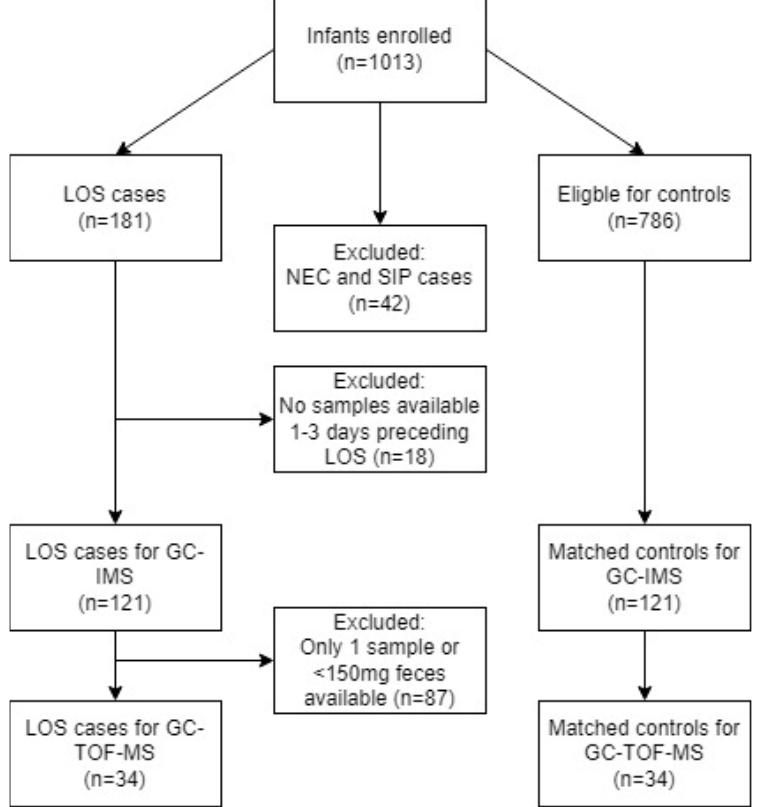
Figure 1. Flow diagram of included preterm infants. A total of 121 LOS cases was included for analysis and matched to 121 controls. Subsequently, 34 LOS cases and controls were eligible for GC-TOF-MS analysis. Abbreviations: GC-IMS, gas chromatography—ion mobility spectrometry; GC-TOF-MS, gas chromatography—time of flight—mass spectrometry; LOS, late-onset sepsis; NEC, necrotizing enterocolitis; SIP, spontaneous intestinal